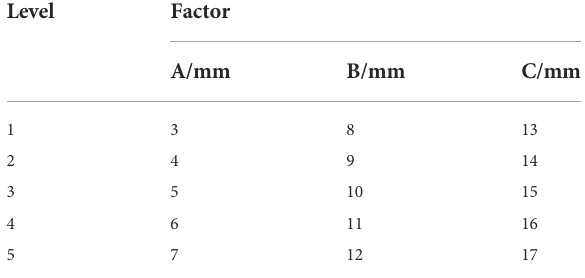
TABLE 4 Factor level table of orthogonal test. TABLE 5 The results of orthogonal